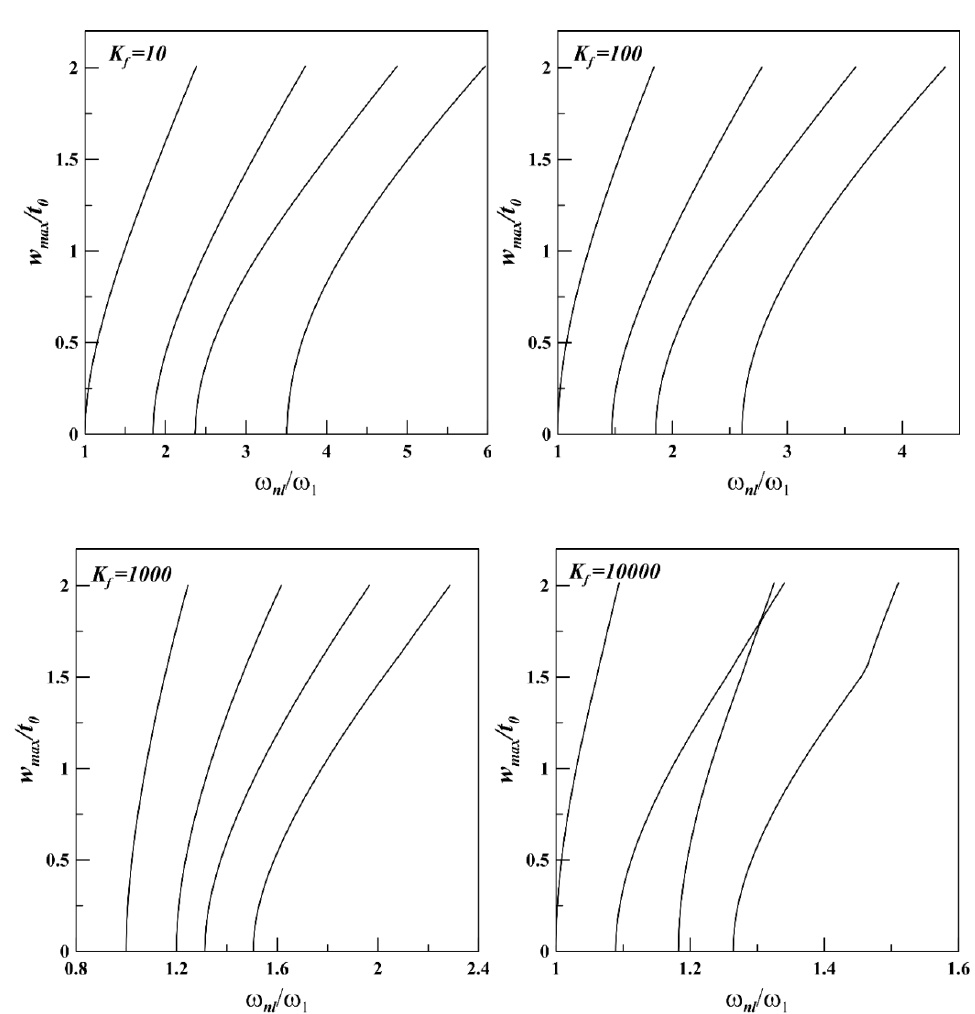
Figure 5: Backbone curves of CCCF plate for various foundation stiffnessat α , β =